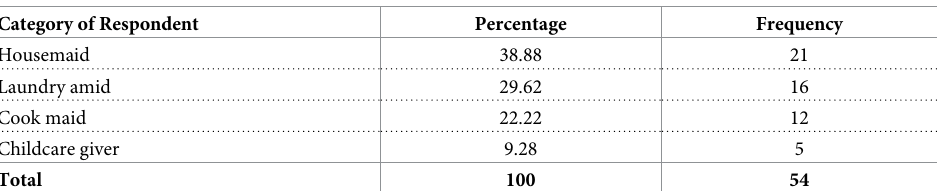
Table 1. Details of